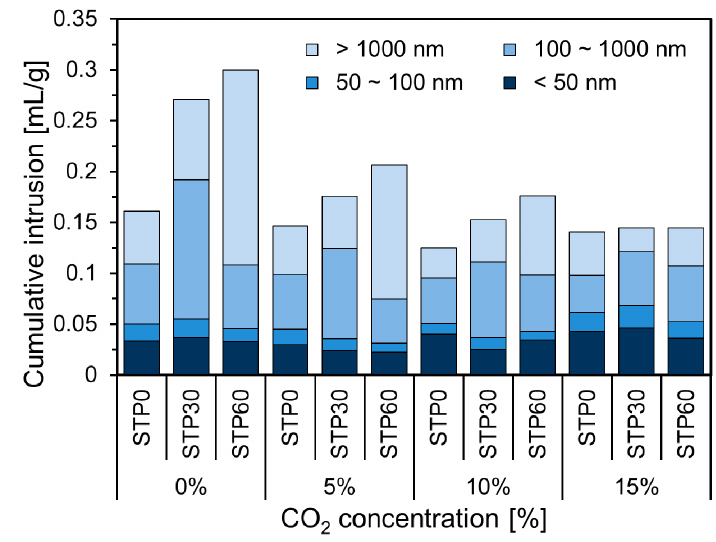
Figure 9. Cumulative intrusion for specimens according to CO 2 concentration.